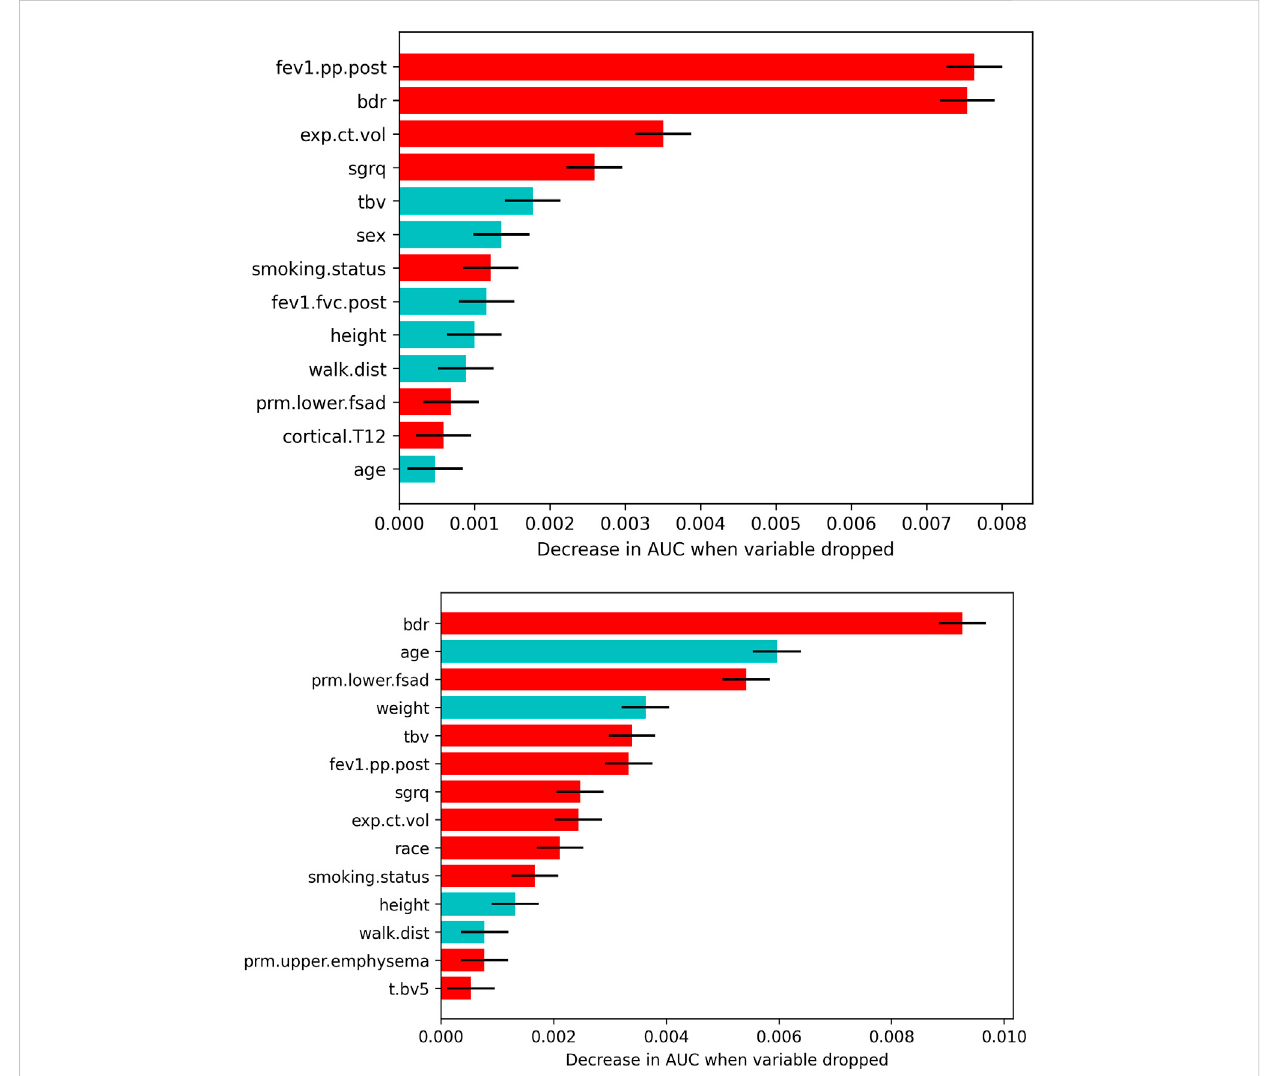
FIGURE 3 Features thatsurvived thedrop-columnvariableselectionprocedureforeach GOLDgroupand modeltype(top:GOLD0;bottom:GOLD 1 – 2).The mean ±1.96 × SD decrease in AUC related to dropping each feature is plotted only for features that signi fi cantly affected the model. Red bars indicate a higherriskofrapidFEV 1 declinewithincreasingvalue,havingbronchodilatorreversibility,AfricanAmericanrace,and/orbeingacurrentsmoker.Bluebars indicate a higher risk of rapid FEV 1 decline with decreasing value and male sex. Abbreviations: fev1.pp.post, post bronchodilator FEV 1 % predicted; bdr, bronchodilator responsiveness; exp.ct.vol, CT-derived expiratory lung volume; sgrq, St. George ’ s Respiratory Questionnaire; tbv, total blood vessel volume; fev1.fvc.post, post bronchodilator FEV 1 /FVC; walk.dist, 6-min walk distance; prm.lower.fsad, PRM lower lobes fSAD > 10%; cortical.T12, average HU value in the cortical region of the T12 vertebra; prm.upper.emphysema, PRM upper lobes emphysema > 2%; t.bv5, ratio of vascular tree length in vessels with a cross-sectional area less than 5 mm 2 to total vascular tree